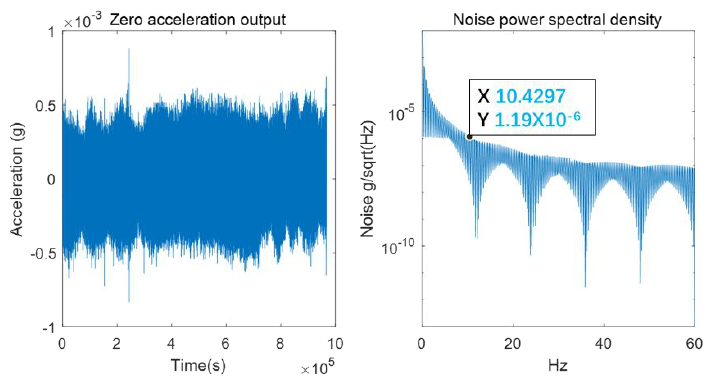
Figure 10. The zero-acceleration output. The Allan deviation of the accelerometer was calculated, and its zero-bias instability was 9.4 µ g, which showed that the device has excellent performance as an inclination detection accelerometer, as shown Figure